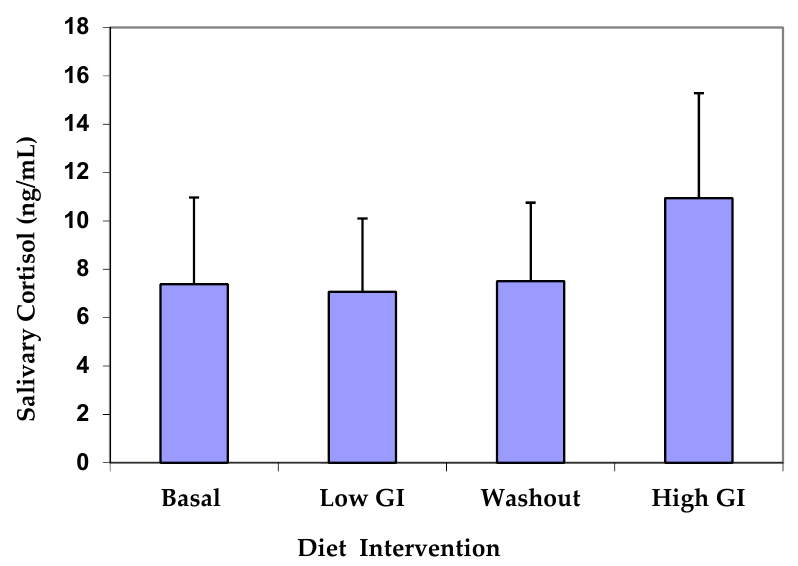
Figure 2. Cortisol concentration for basal, after low-GI diet, washout period and high-GI diet.